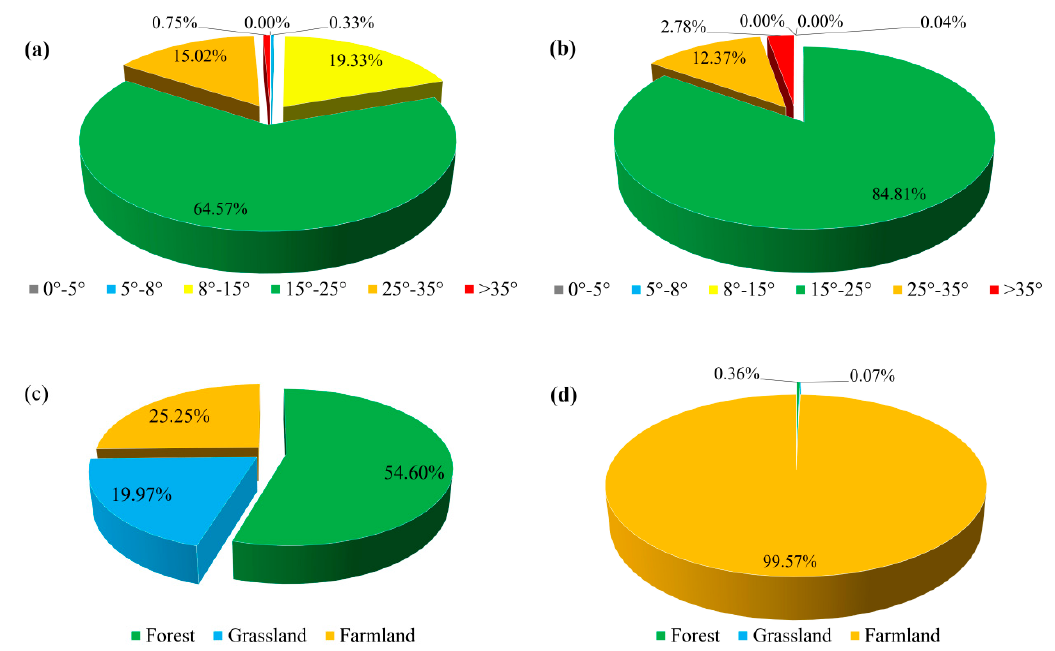
Figure 12. Intersection between high and very high soil erosion risk areas with the slope gradient and land use. ( a ) High soil erosion risk class integrated with slope gradient. ( b ) Very high soil erosion risk class integrated with slope gradient. ( c ) High soil erosion risk class integrated with land use. ( d ) Very high soil erosion risk class integrated with land use.